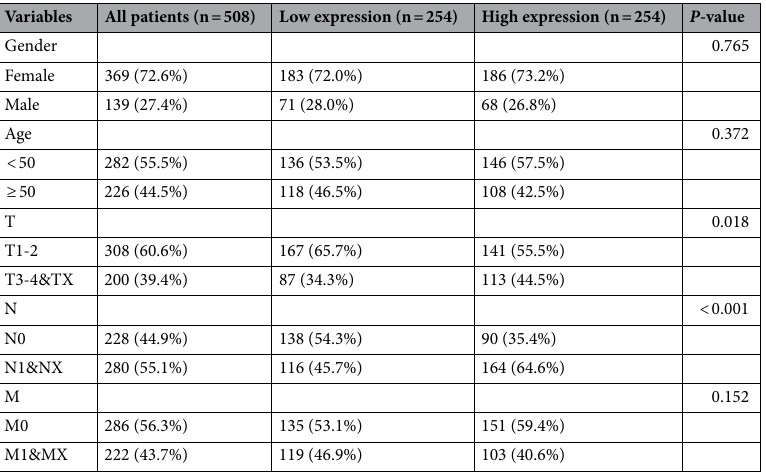
Table 1. Baseline data of patients with THCA in TCGA database. A P -value of < 0.05 was considered significant.